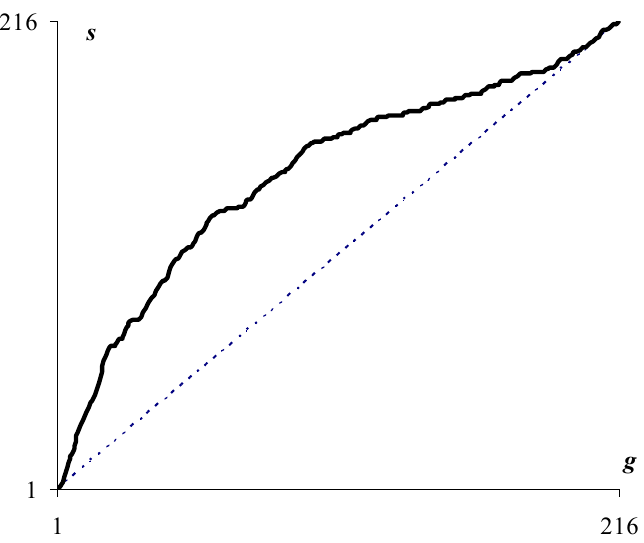
Figure 3. The number s of superpixels as a function of the number g of optimal image partitions involved in dividing N pixels into superpixels due to the accumulation of boundaries between clusters. The dotted curve shows the case of hierarchical optimal approximations.